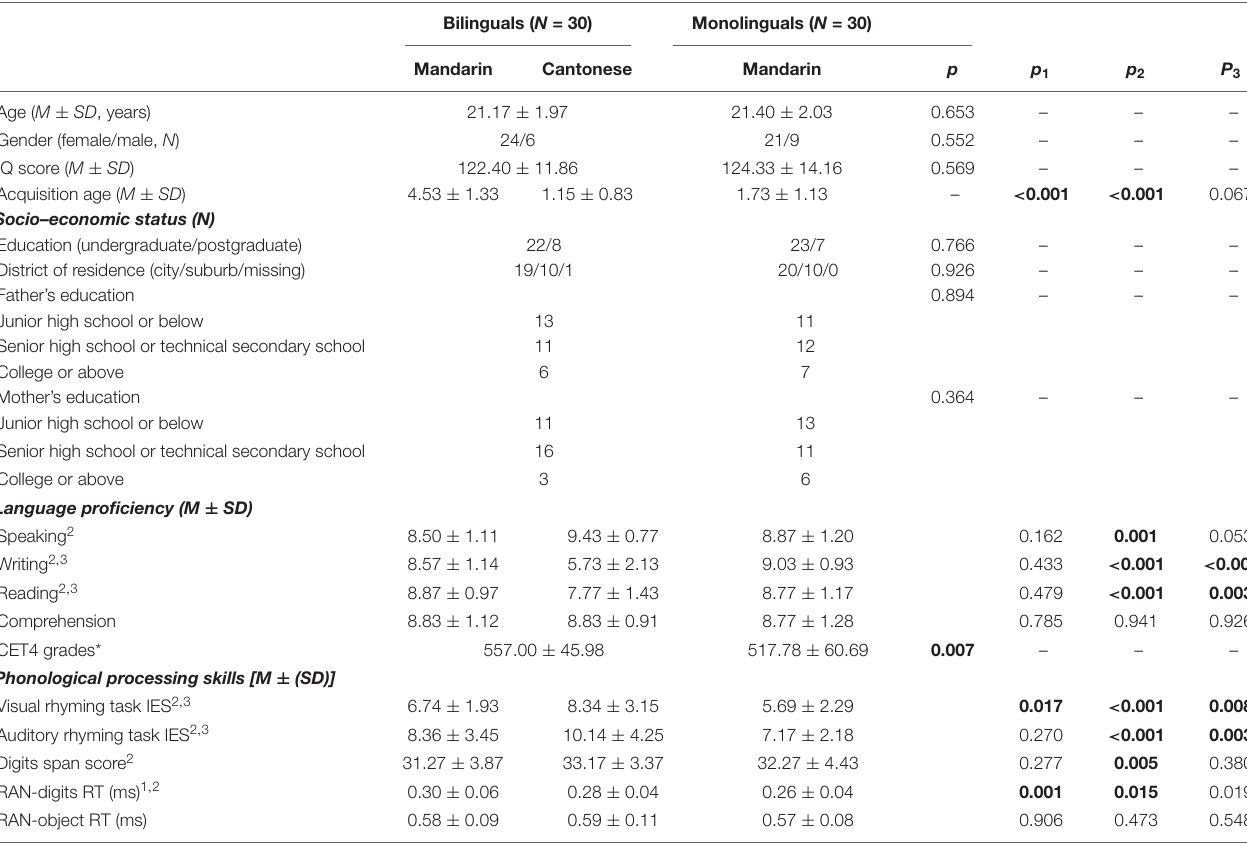
TABLE 1 | Demographic characteristics and phonological processing